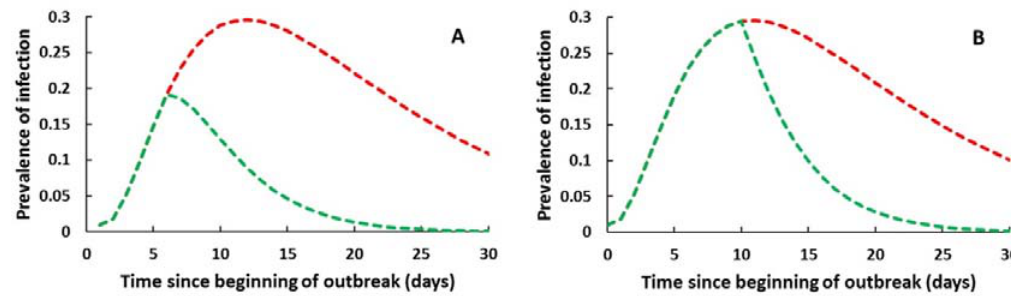
Figure 3. Effect of chemoprophylaxis on the total number of leptospirosis cases. Prevalence of infection (total cases) without (red line) and with (green line) chemoprophylaxis initiated at day 5 ( A ) and at day 10 ( B ) at a rate (1/ θ ) of 0.2.